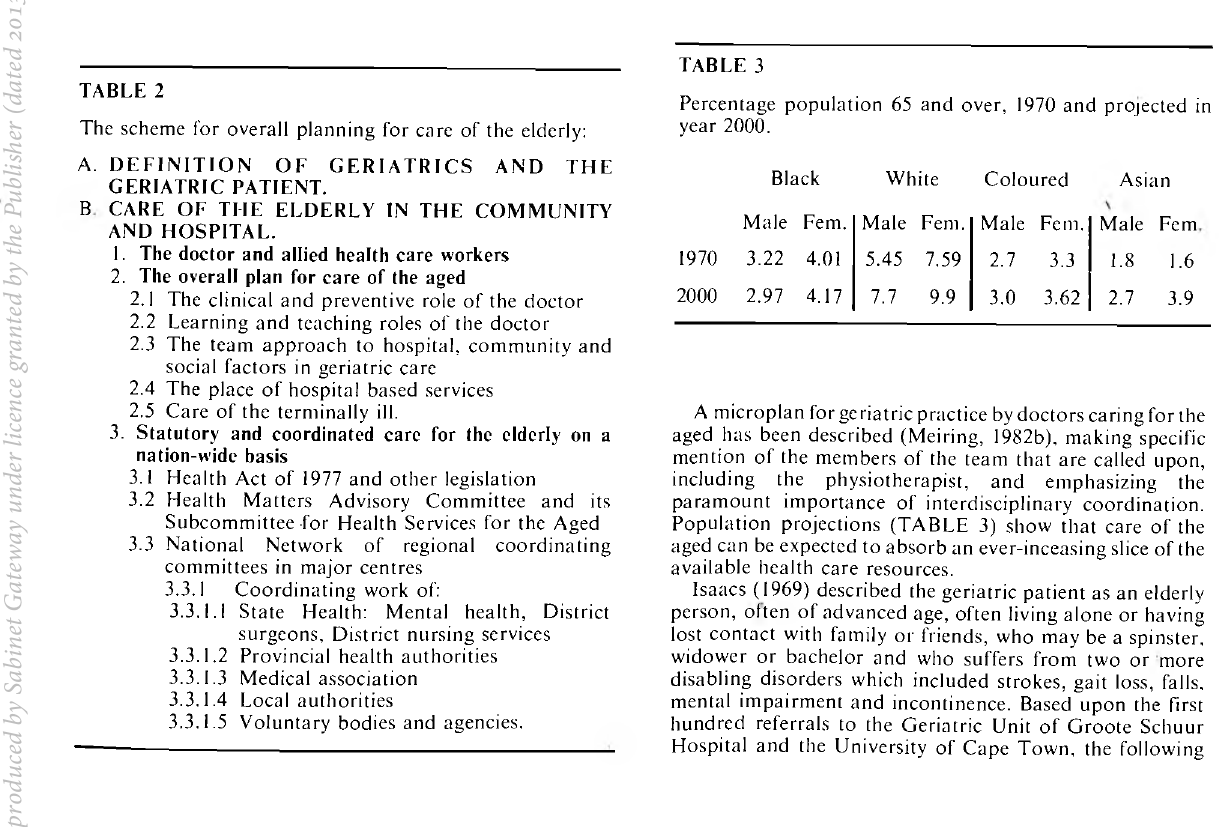
Fig. I. An ideal How system for a hospital based geriatric service, taken from a typical U.K. Geriatric Unit. * Indicates the likely degree of involvement of physio­ therapy services as seen by the geriatrician.